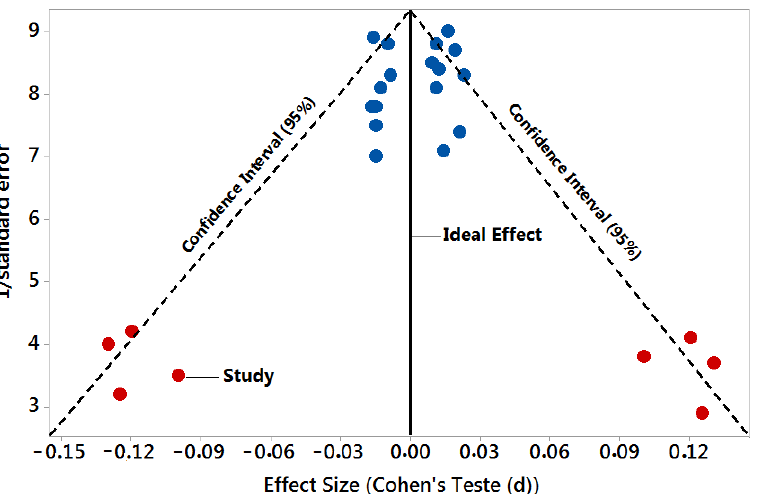
Figure 1. The symmetrical Funnel Plot does not suggest a risk of bias between the small-sample-size studies that are shown at the bottom of the graph. High-confidence and high-recommendation studies are shown above the graph (blue balls).